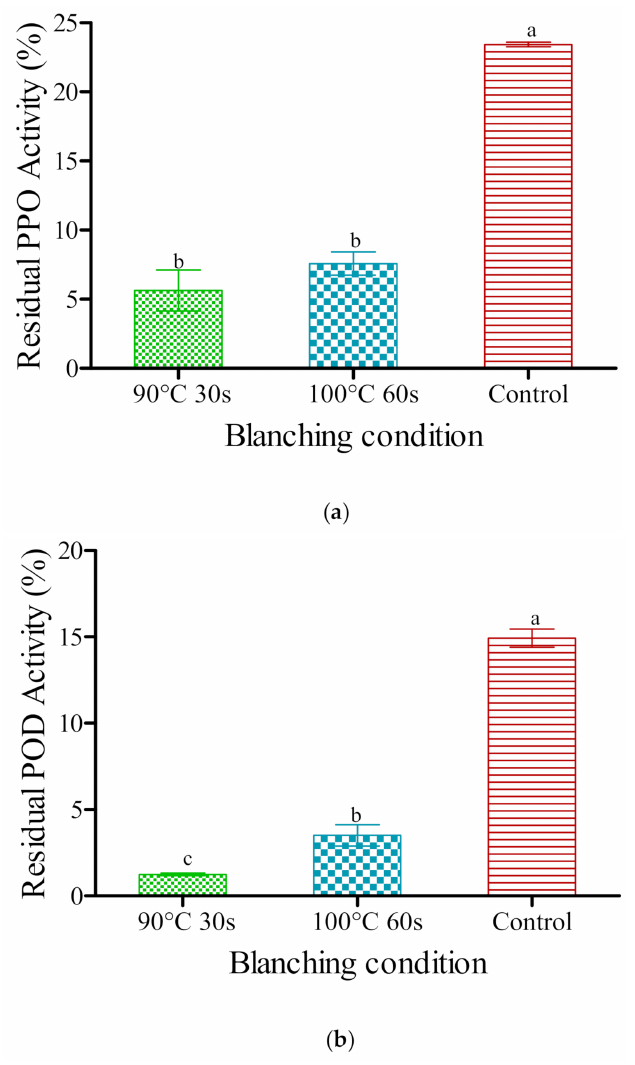
Figure 1. Effects of blanching conditions on the residual ( a ) polyphenol oxidase (PPO) and ( b ) peroxidase (POD) of dried pomegranate aril cv. Wonderful. (Data presented as means ± SE. Bars followed by different letter(s) are significantly different ( p < 0.05) according to Fisher’s LSD). Table 1. Changes in colour attributes of fresh and dried pomegranate arils for different blanching